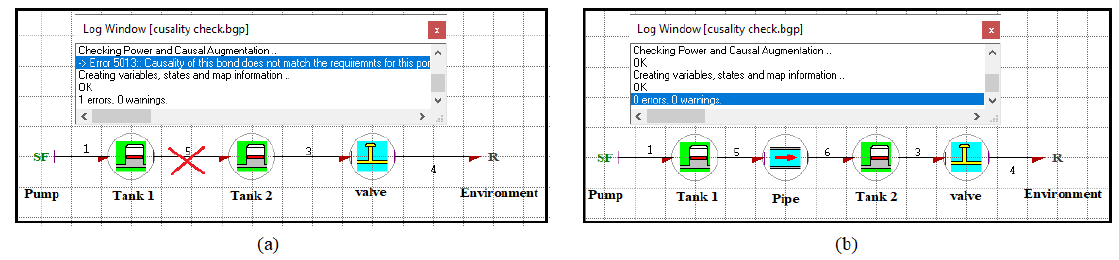
Figure 7. ( a ) Invalid and ( b ) Valid connection of